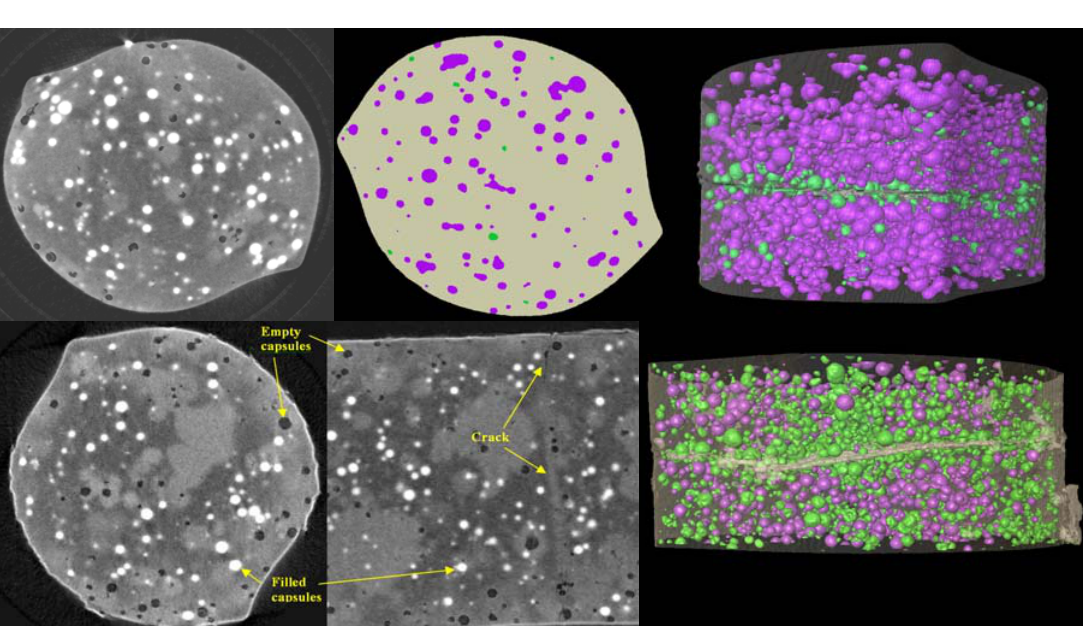
Figure 11. Upper row; a tomographic cross section, a segmented cross section and a 3D rendered view of the seven-day healed sample showing full capsules as purple and empty ones as green (sample diameter 2 mm). Note the band of empty capsules around the crack. Lower row; two tomographic sections in different orientations and a 3D rendered view of the three-month healed sample. Note the much higher proportion of empty capsules in regions away from the crack relative to the seven-day healed